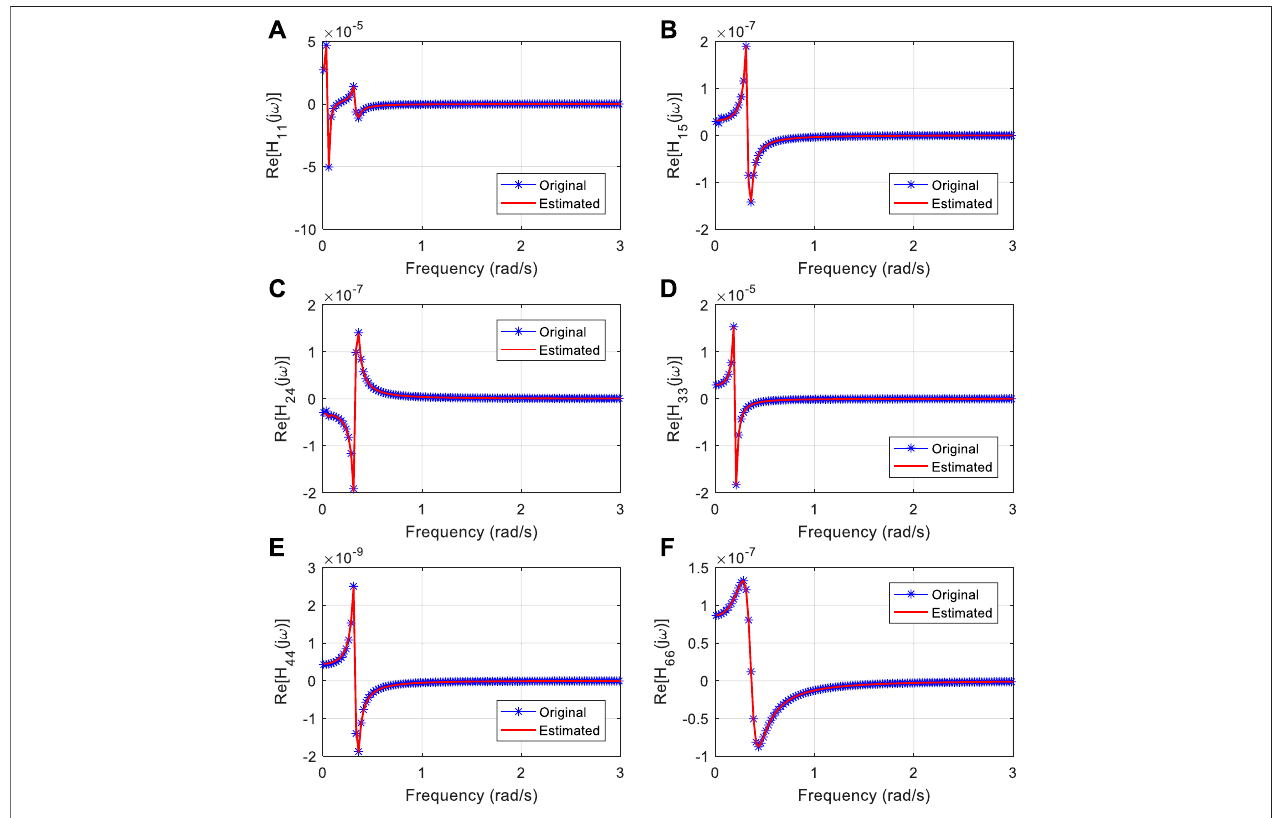
FIGURE 5 | Real-part comparison of the original and estimated transfer function. (A) H11(jw); (B) H15 (jw); (C) H24(jw); (D) H33(jw); (E) H44(jw) and (F) H66(jw).